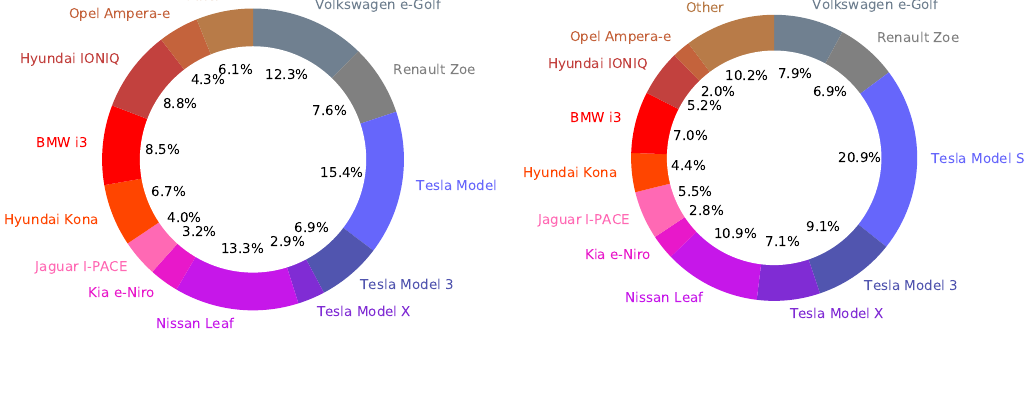
Figure 2. Distribution of vehicle types in the sample ( left ) and in the Netherlands ( right ).